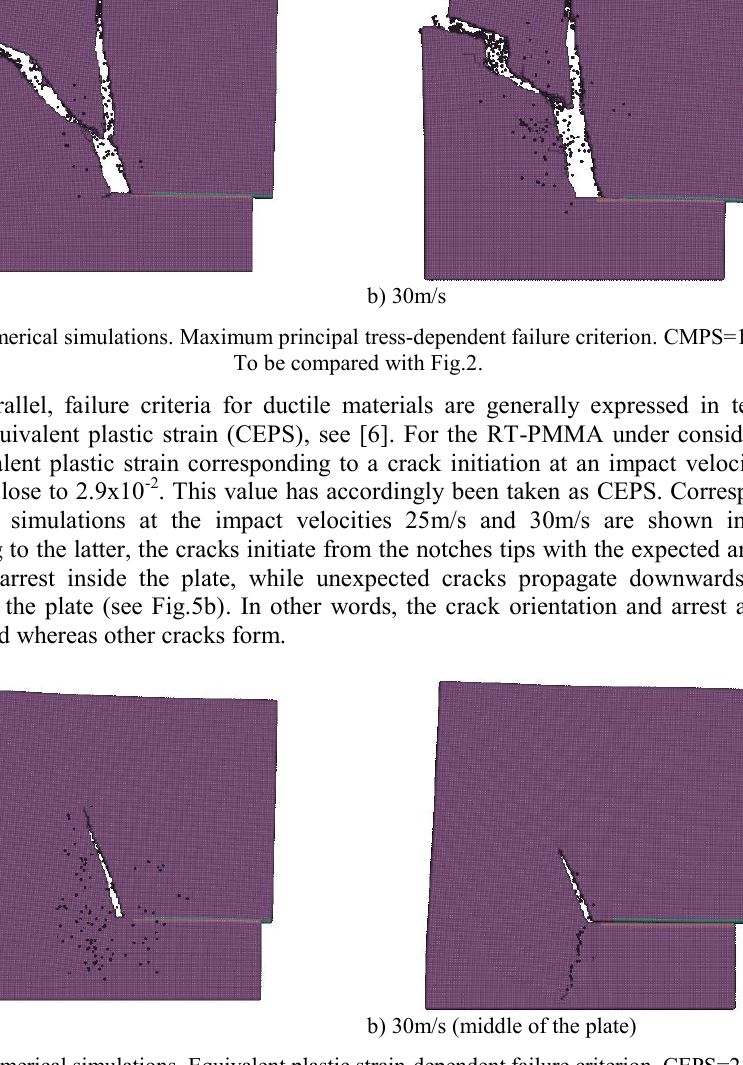
Fig. 5. Numerical simulations. Equivalent plastic strain-dependent failure criterion. CEPS=2.9x10 -2 . To be compared with